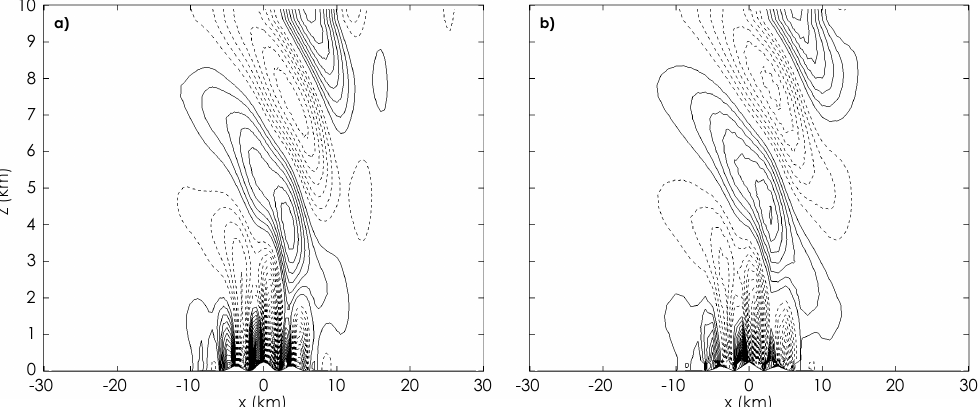
Figure 8. Steady-state solution for the simulation of the Schaer et al. (2002) test case: contours of vertical velocity for (a) N = 0 . 01s − 1 and (b) N = 0 . 01871s − 1 . Solid (dashed) lines indicate positive (negative) values. Contour intervals are (a) 0.05ms − 1 and (b) 0.09355ms − 1 , respectively.